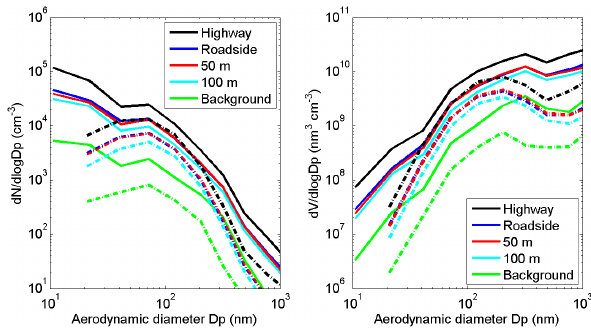
Figure 4. Average particle number size distribution (left) and vol- ume size distribution (right) measured at different distances from the highway at Herttoniemi with two ELPIs, one measured before (solid lines) and the other after (dash dot lines) the thermodenuder. Note that the x axis refers to aerodynamic